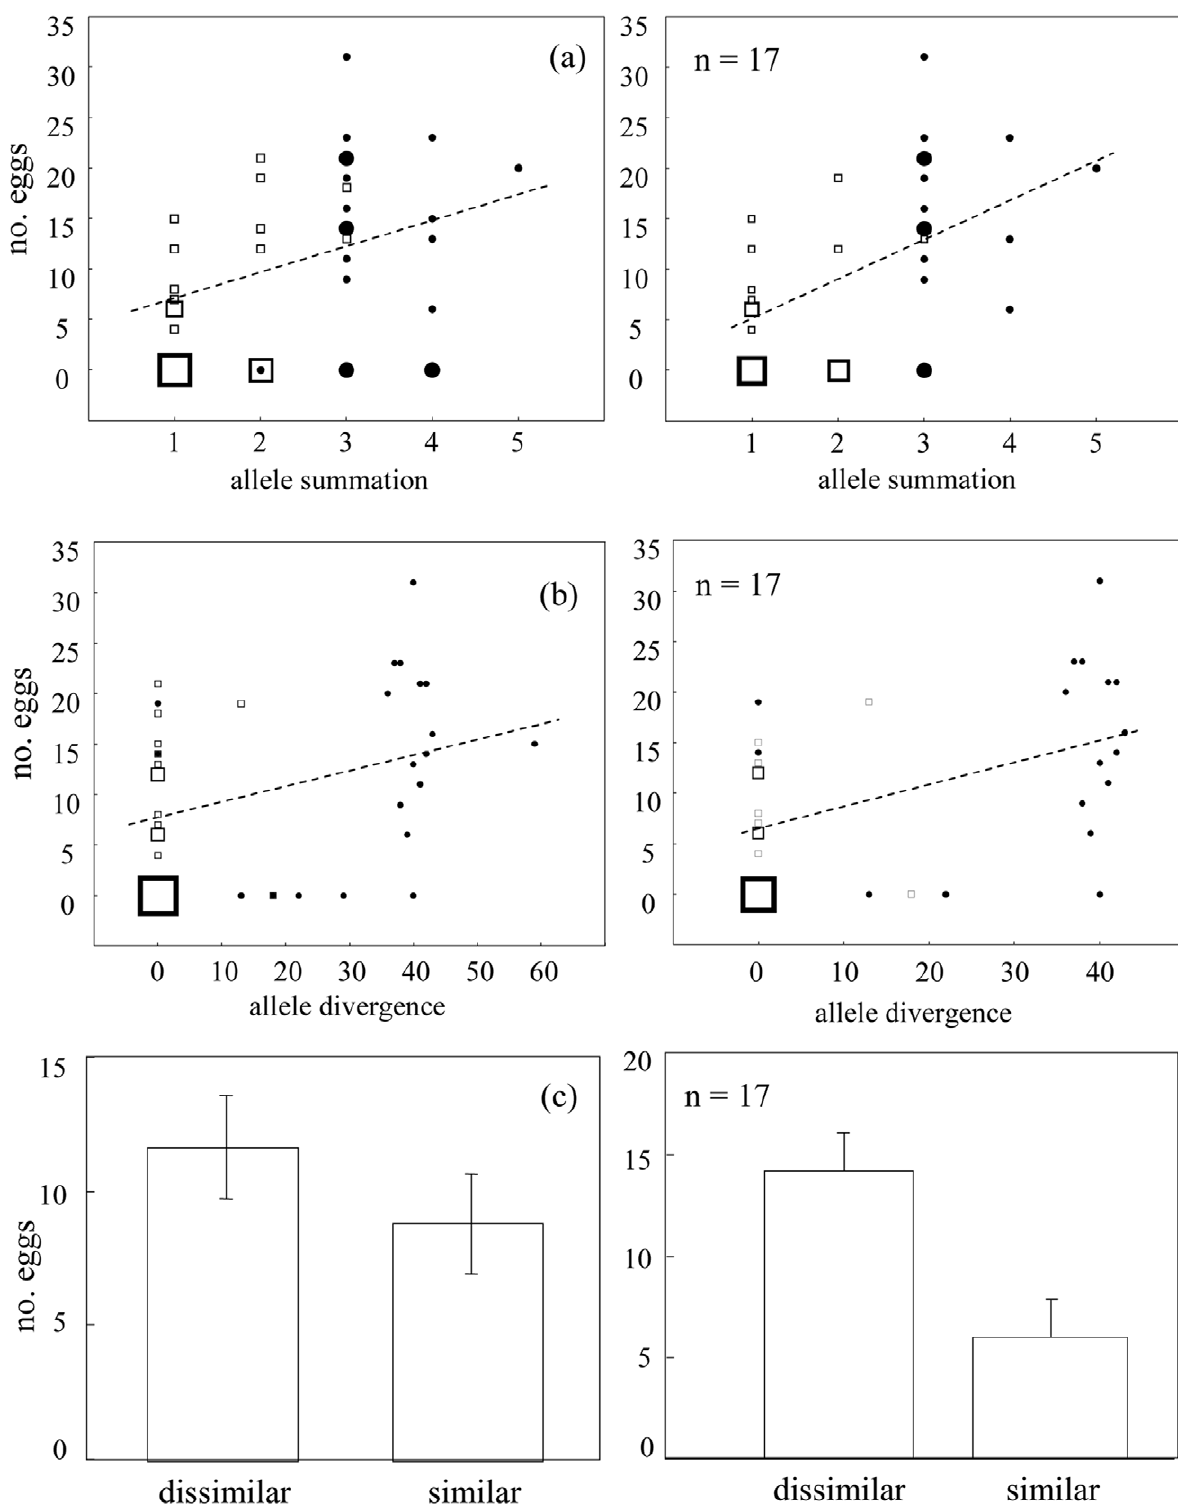
Figure 1. Relationship between measures of mate dissimilarity and female choice. The measures of mate dissimilarity were (a) allele summation, (b) allele divergence and (c) simple contrast. Full (n=20, left panel) and limited (n=17, right panel) datasets were used for calculation. Female choice was measured as the number of eggs deposited by females when spawning with a particular male. Symbol size (a, b) represents the level of overlap of individual data points, with a maximum of 6 overlapping points (the largest square). The line represents the best fit of a simple linear regression. Error bars (c) represent 6 1 standard error.